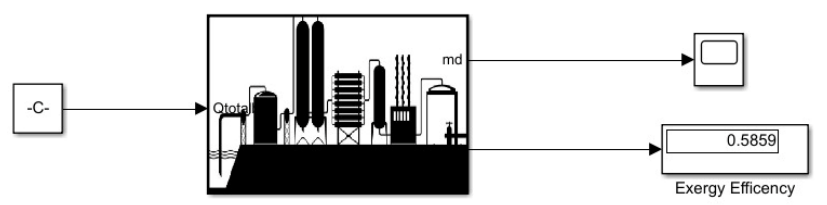
Figure 6. Desalination Simulink model.